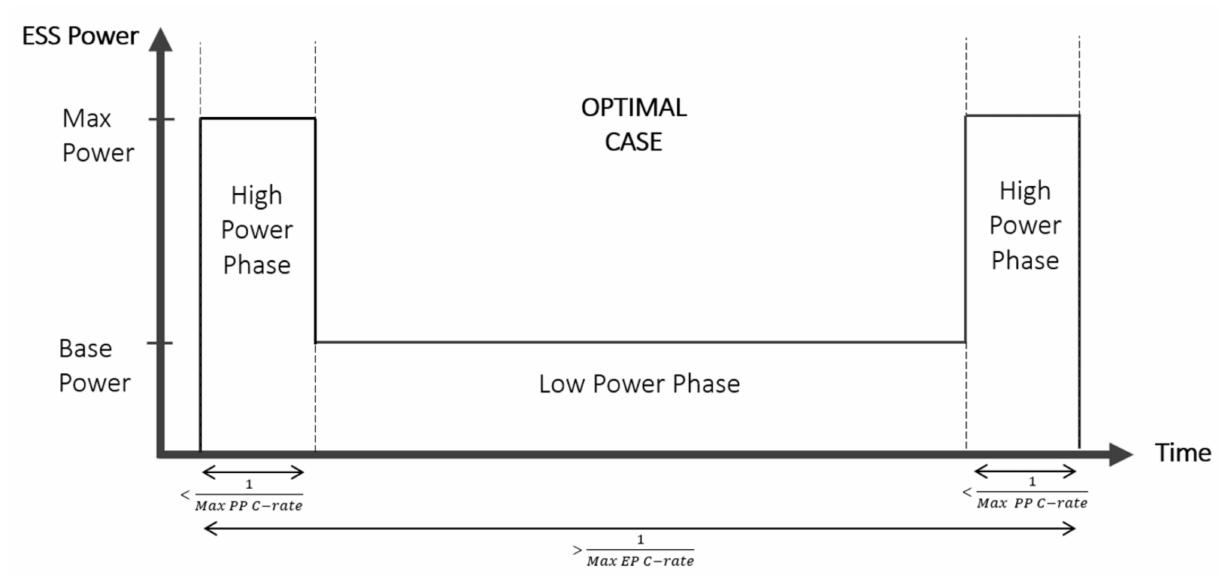
Figure 11. The optimal duty cycle that requires the high power phase duration to be less than or equal to the power pack (PP) discharge time at the maximum C-rate and the entire duty cycle duration must be higher than or equal to the energy pack (EP) minimum discharge duration at the maximum C-rate.